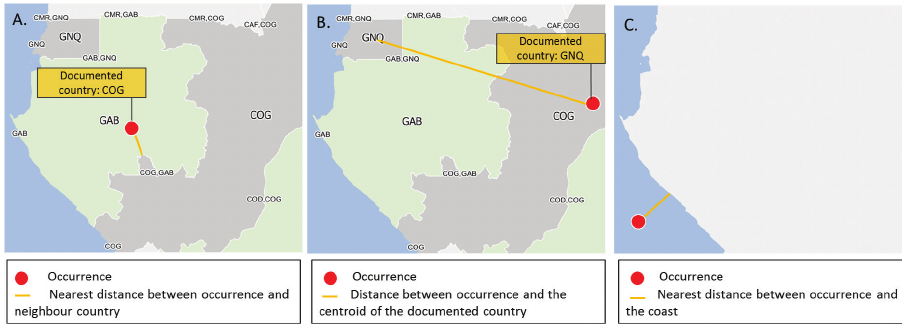
Figure 2. Examples of the georeferencing verification process. a The georeferenced record falls within a neighbouring country (here Gabon - GAB) of its documented country (here Republic of the Congo - COG). The nearest distance between the occurrence and the border of the documented country is computed b The georeferenced record falls within a non-neighbouring country (here Equatorial Guinea - GNQ) of its documented country (here Republic of the Congo). This record is classified as ‘Error’ and is discarded c The georeferenced record lies beyond the coastline. The nearest distance between the occur- rence and the coastline of the documented country is